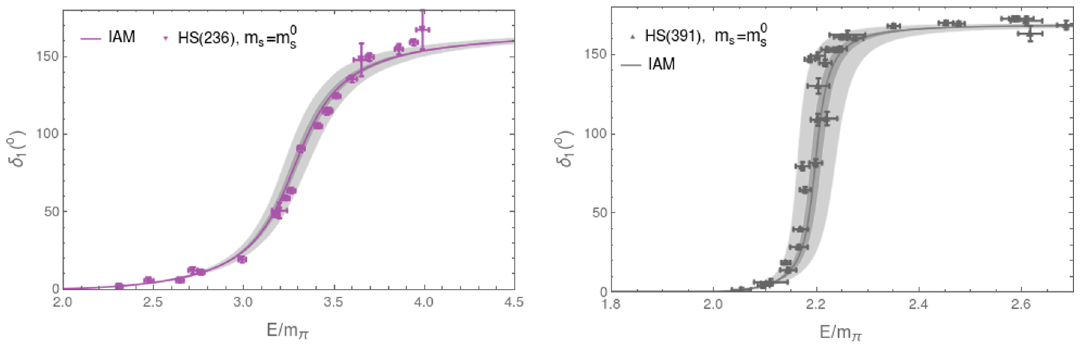
Figure 17 . Result of Fit IV in comparison with the HS data at m (cid:25) = 236 and 391 MeV [63, 64]. experiment. In (cid:12)gure 21, the CLS D101 ensemble and HS data for m plotted together. We can see that indeed both results are